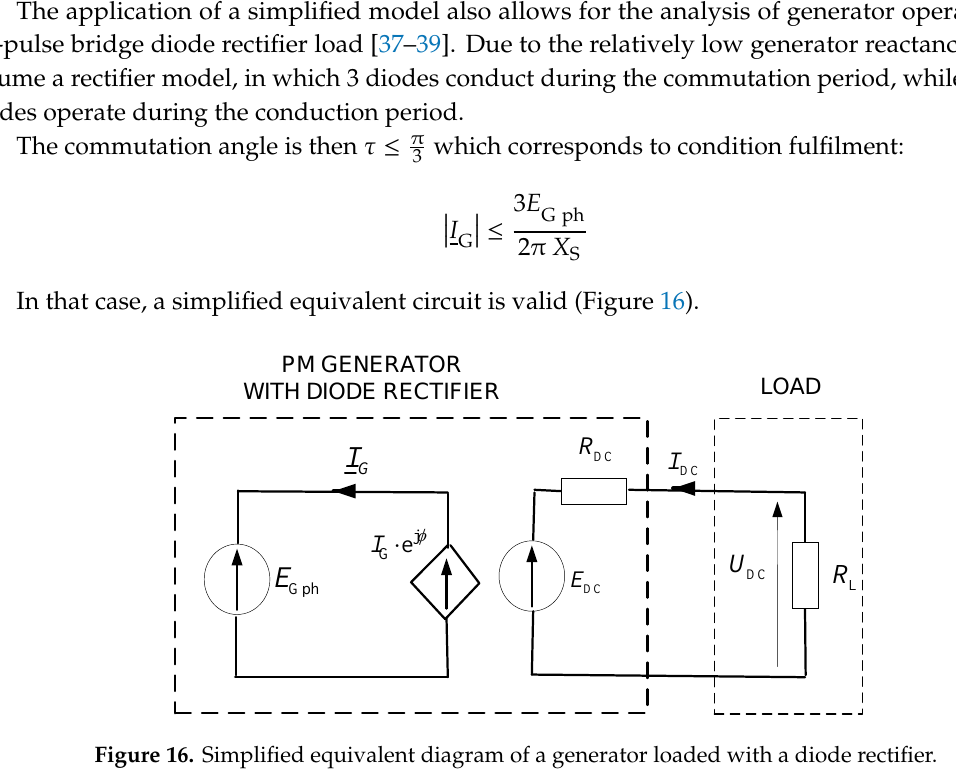
Figure 16. Simplified equivalent diagram of a generator loaded with a diode rectifier.